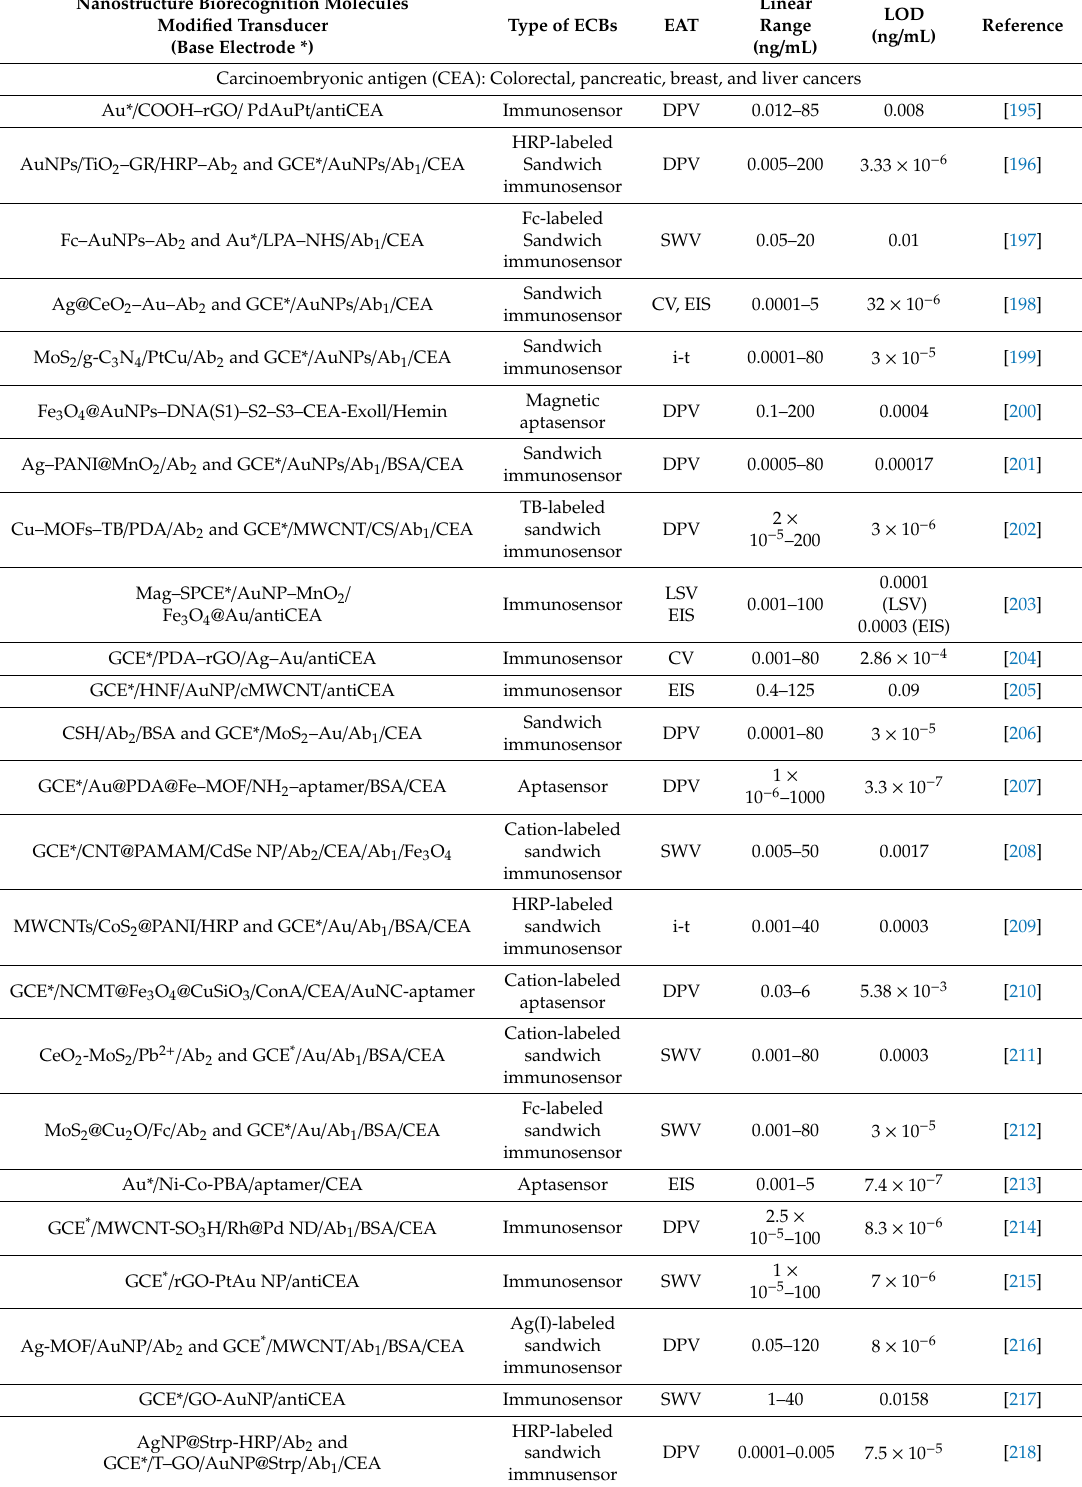
Table 3. MNP-based ECBs for the detection of cancer biomarkers. The table discusses the transducer design and biomarker detection processes, (*) is used to tag base electrode